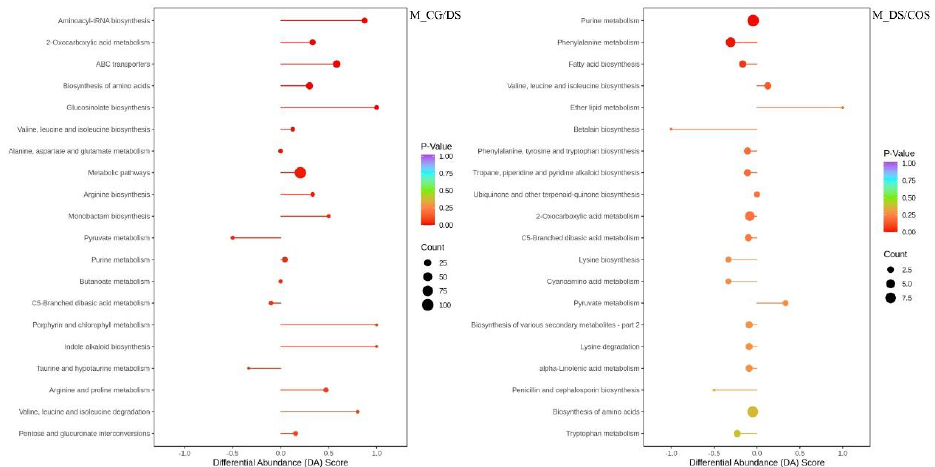
Figure 4. Top-20 KEGG pathway enrichment of SDMs in the DS and COS treatment groups compared to the control group (CG/DS; left panel) and to each other (DS/COS; right panel) as a function of differential abundance (DA) score. The size of the circles corresponds to number of DEGs and are color-coded according to p-value.